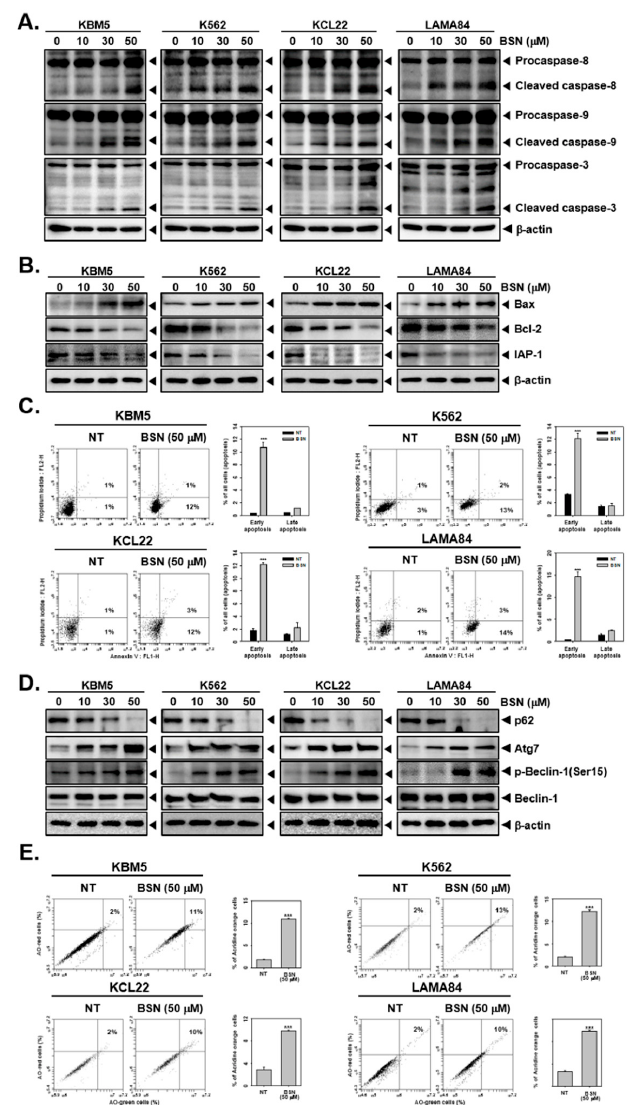
Figure 2. BSN induces both apoptosis and autophagy. ( A , B ) KBM5, K562, KCL22, and LAMA84 cells were incubated with BSN (0, 10, 15, 30, 50, 100 μ M) for 24 h and immunoblotting was carried out. ( C ) The cells were treated with BSN (50 μ M) for 24 h and apoptotic cells were analyzed by Annexin V assay. ( D ) The cells were treated as described above in panel A; Western blotting for various proteins was carried out. ( E ) The cells were treated as described above in panel B; autophagy was measured by acridine orange assay. Data represent mean ± SD. *** p < 0.001 vs. non-treated (NT) cells. The results shown are representative of the three independent experiments.